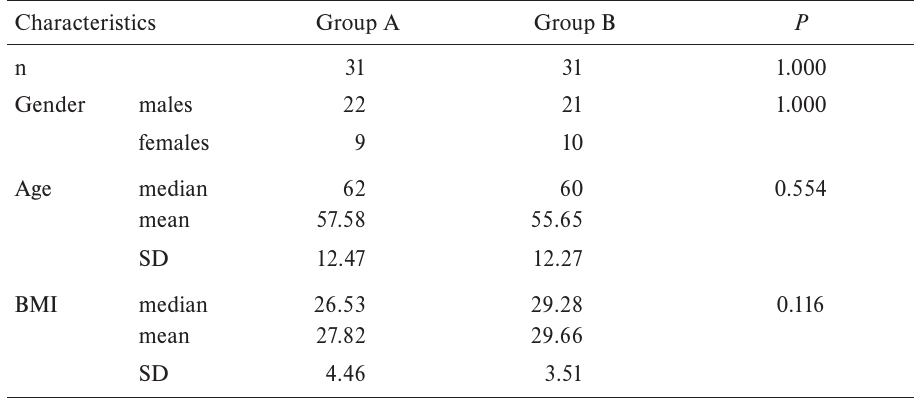
Table 1. Demographic comparison of patients Groups A (n=31) and B (n=31).